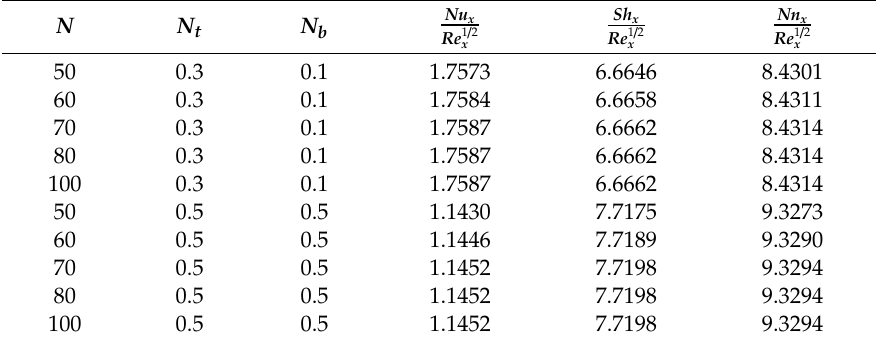
Table 2. Comparison of the current outcomes for − θ (cid:48) ( 0 ) and − φ (cid:48) ( 0 ) with the previous investigations across N t and N b by taking P r = L e = 10, M = β D = F r = G r N b N